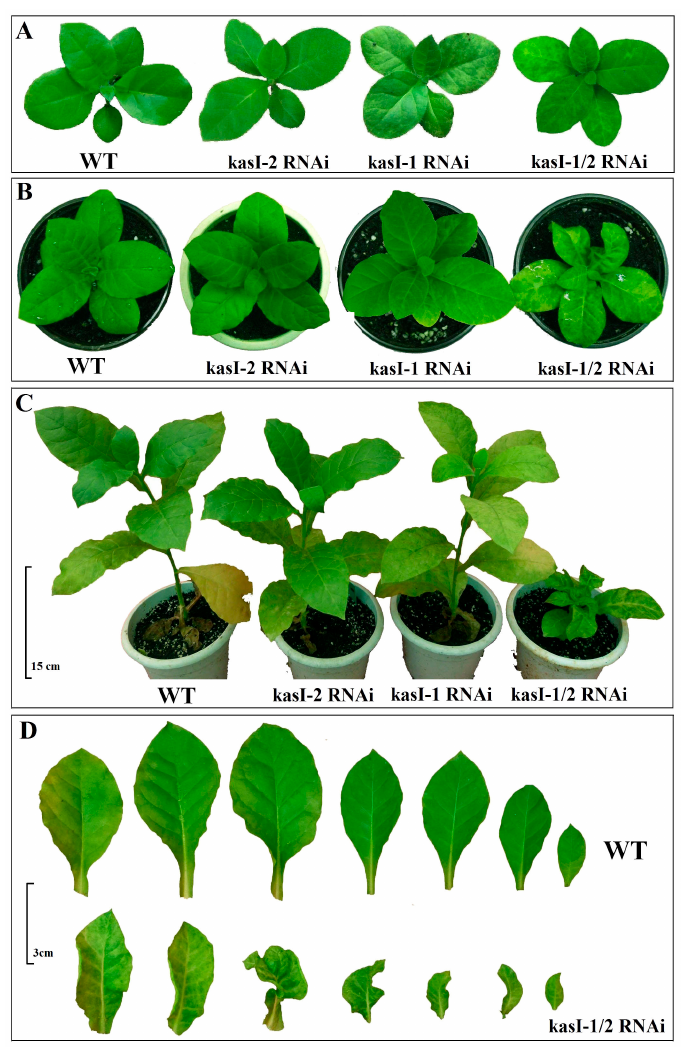
Figure 6. Growth and morphology of Wild-Type (WT) tobacco and kasI-1 RNAi, kasI-2 RNAi, kasI-1/2 RNAi plants: ( A ) phenotypic observation of two-month-old plants; ( B ) phenotypic observation of three-month-old plants; ( C ) phenotypic observation of four-month-old plants (bar = 15 cm); and ( D ) comparison of leaf morphology between WT plant and kasI-1/2 RNAi plant (three-months-old plant, bar = 3 cm).